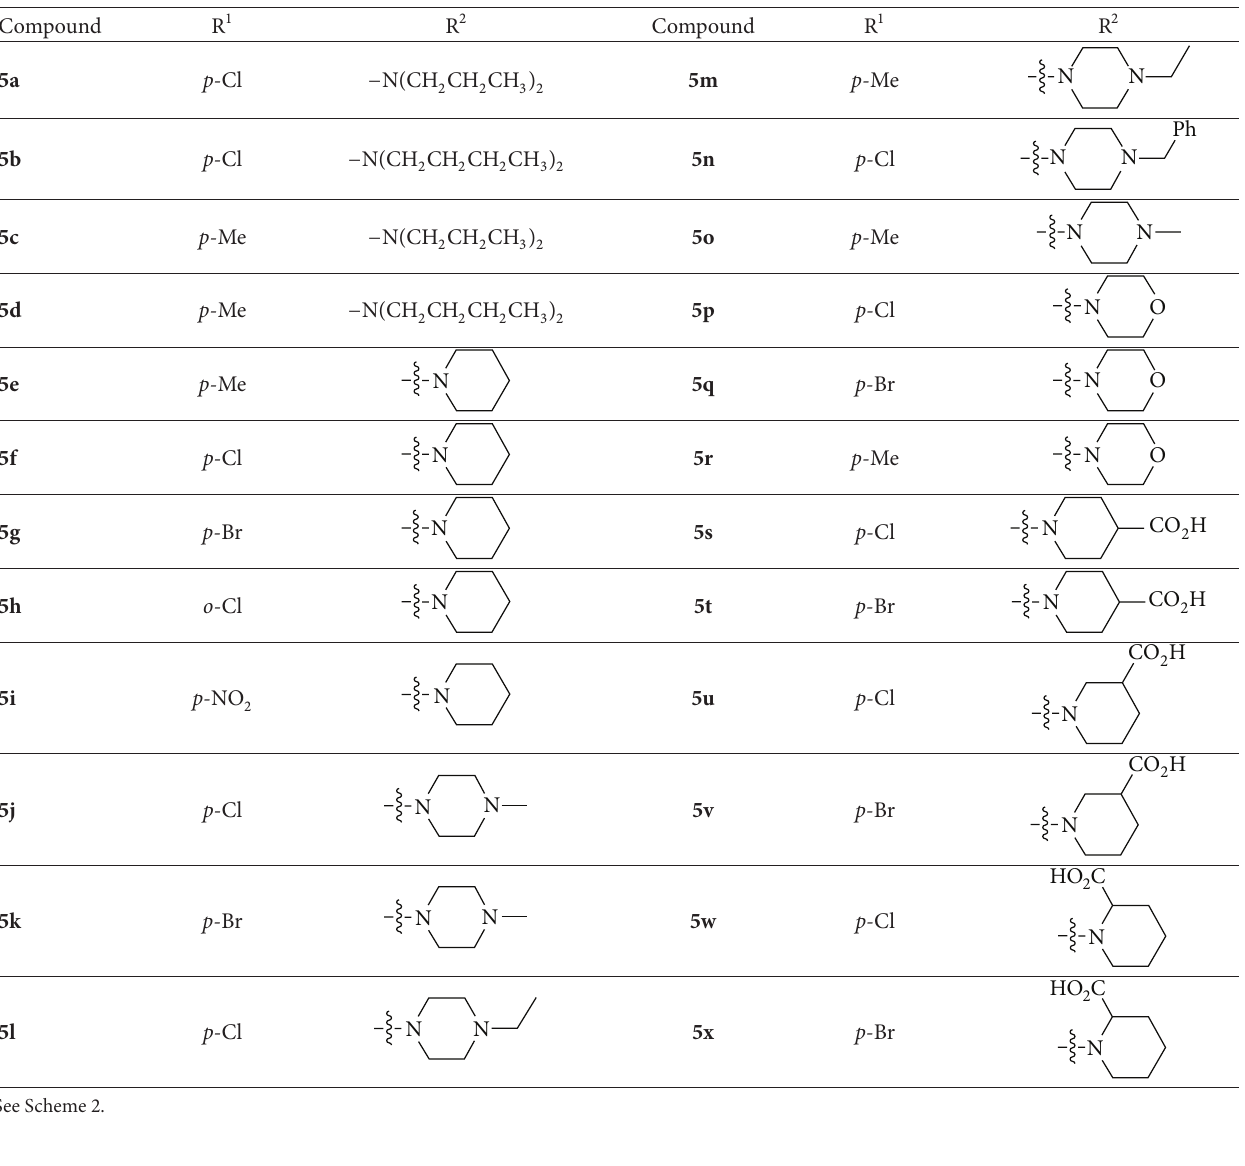
Table 1: Chemical structure of the target compounds 5a – 5x